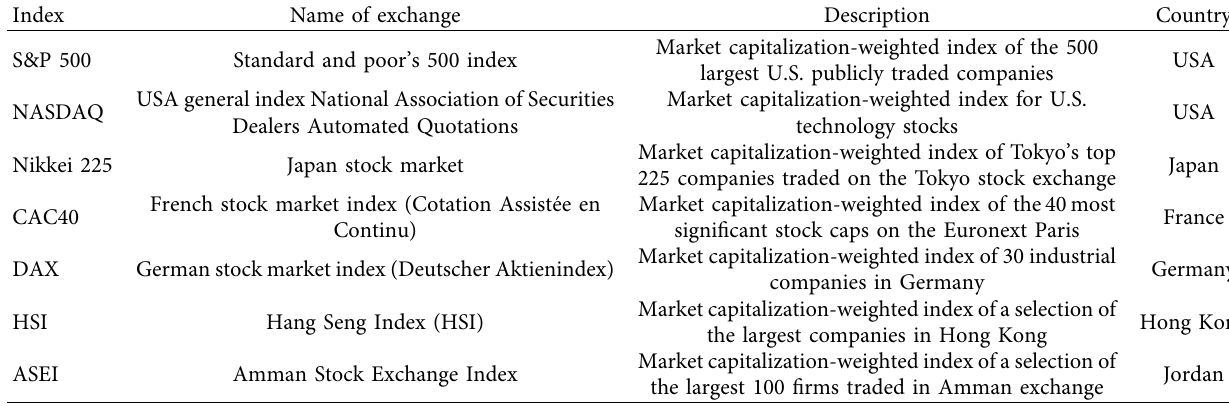
Table 1: Description of our sample for the stock market indices.